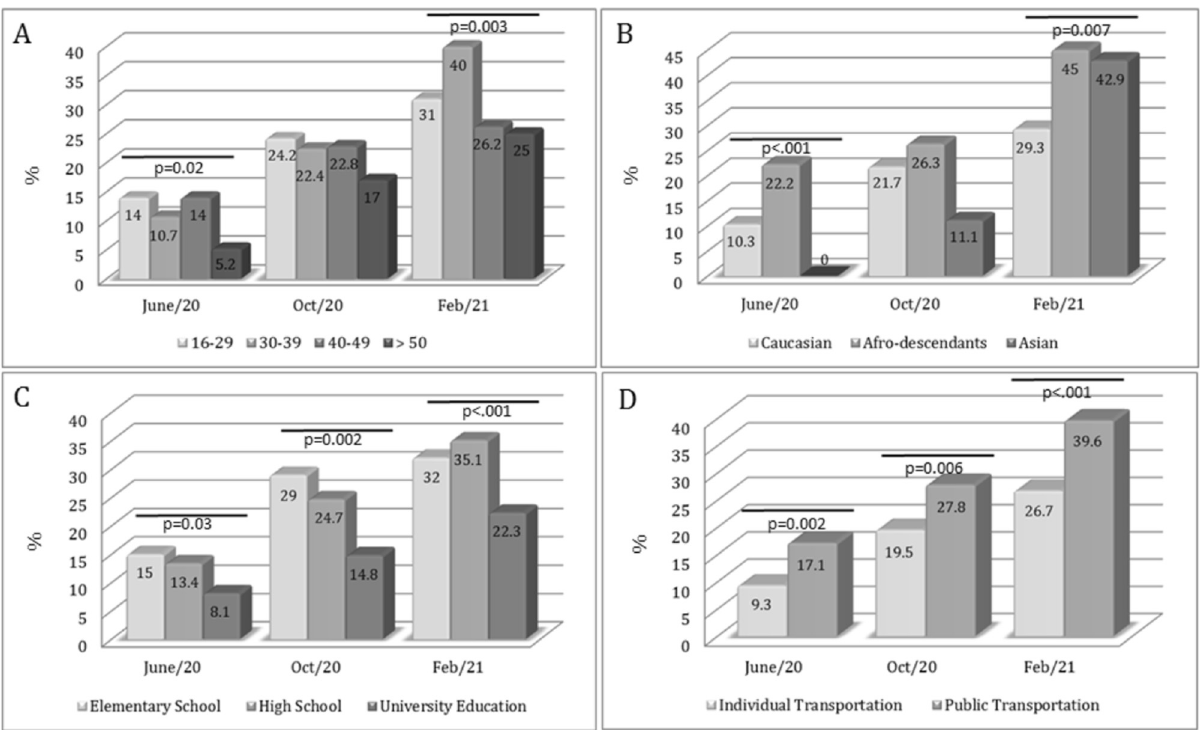
Fig. 2. Percentage of seroprevalence of anti-SARS-CoV-2 antibodies in the three periods evaluated in accordance with the age groups (A), race (B), school grade (C) and use of public transportation (D). The comparisons among seroprevalences over the categories were performed by Qui-Square test and those with signi fi cant differ- ences are shown by lines above the bars with the respective